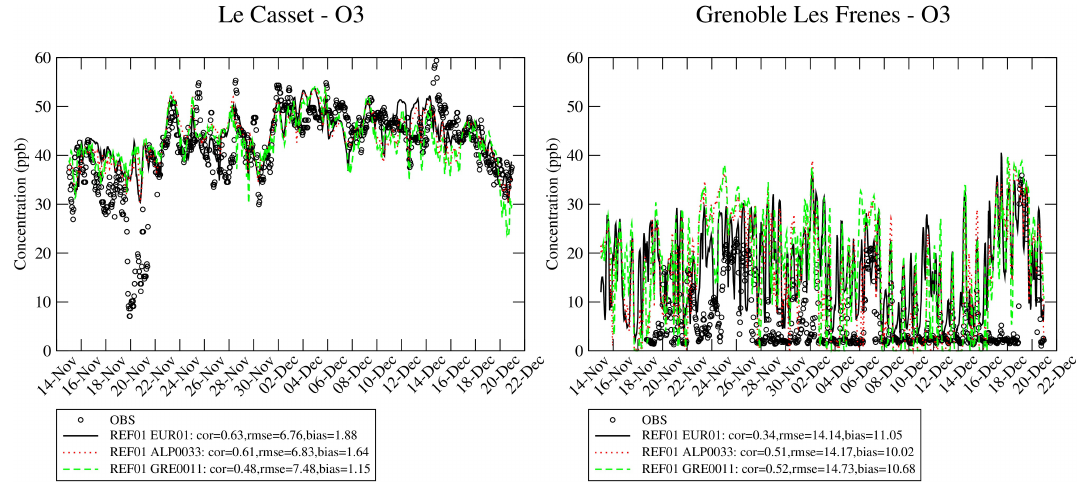
Hourly timeseries of predicted (EUR01, ALP0033, GRE0011) and observed ozone concentrations (ppb) at two sites. “Le Casset” is a national rural background station, Grenoble is an urban